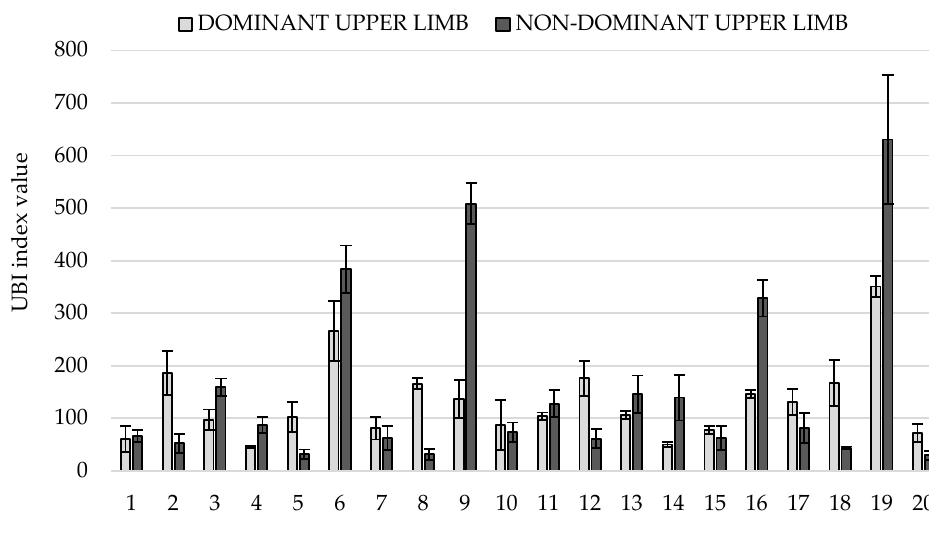
Figure 5. Data obtained for the Upper Body Index indicator for the stroke patient group. Table 9. Data obtained for the Upper Body Index indicator in the reference